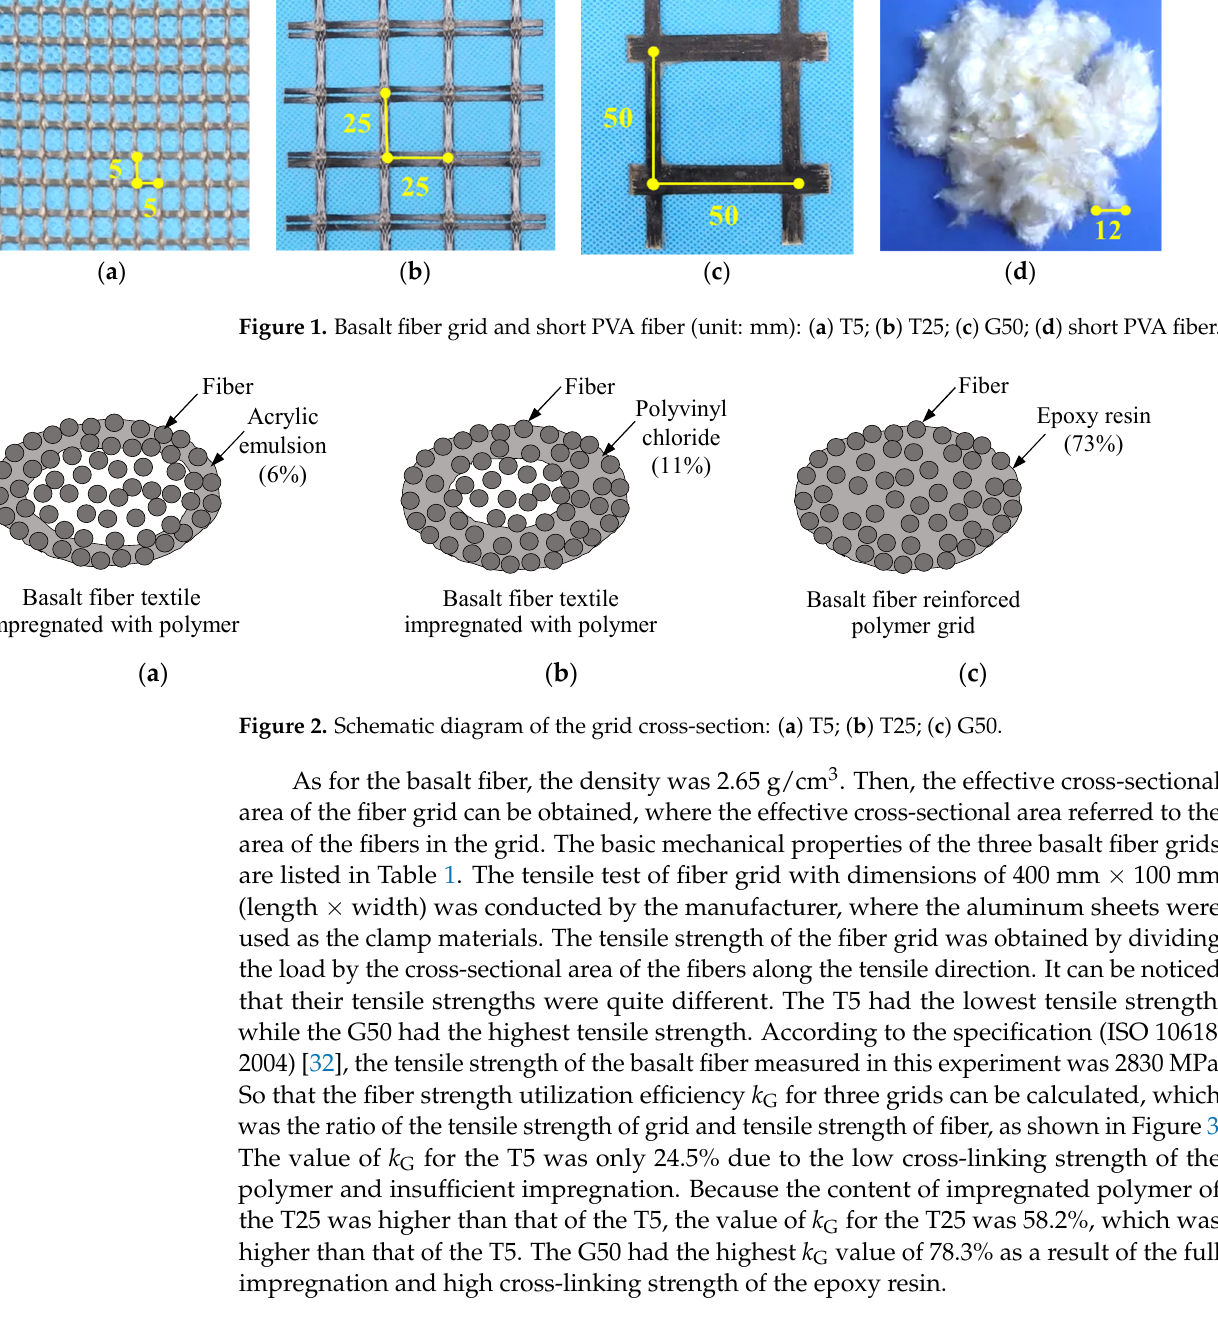
Table 1. Properties of the basalt fiber grid.